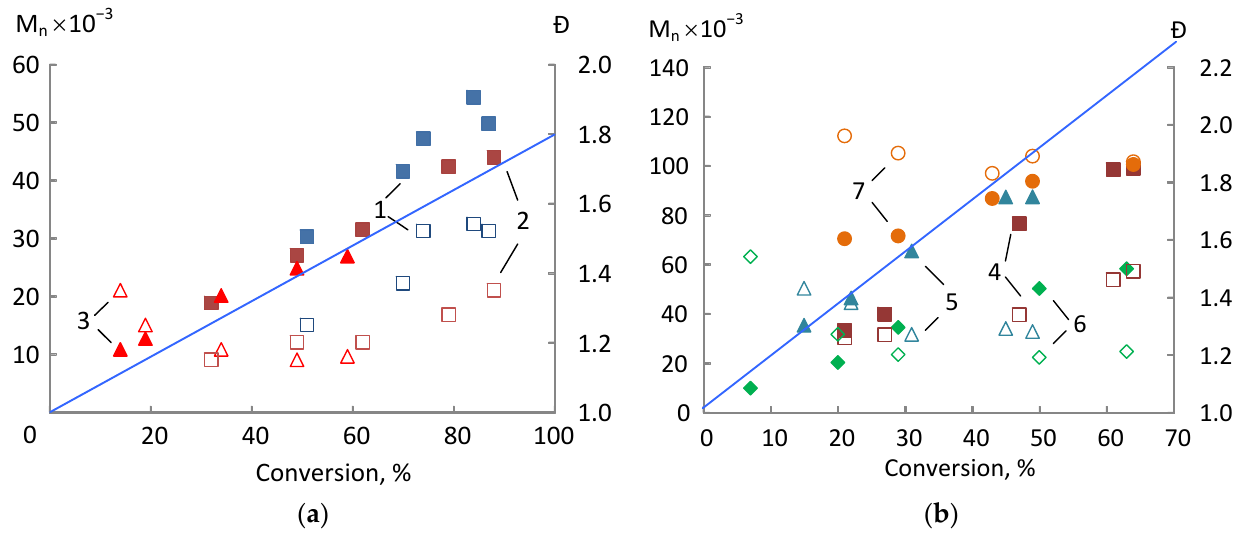
Figure 2. The dependences of M n (filled markers) and Đ (empty markers) on conversion for AN polymerization. Strait line—theoretically calculated values. ( a) – [AN]:[initiator]=912:1; ( b) –